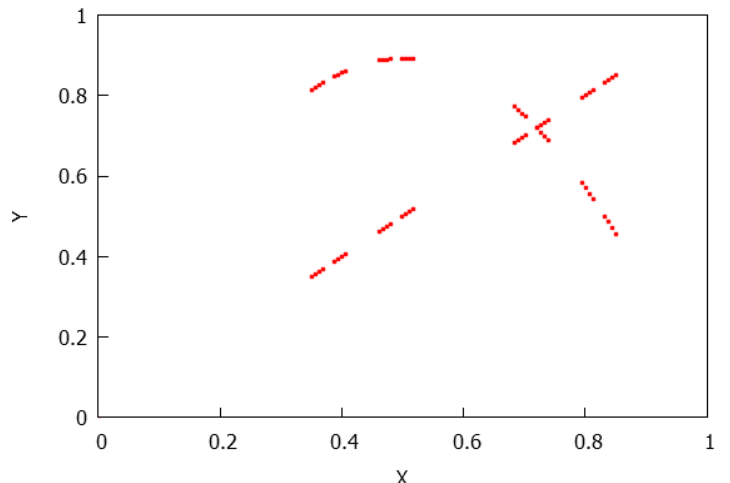
Figure 27. The transitive map f ( x ) = λ ∞ x ( 1 − x ) originates the ω -limit set ω F (( x 0 , x 0 )) = ∆ | C ∪ Γ f | C